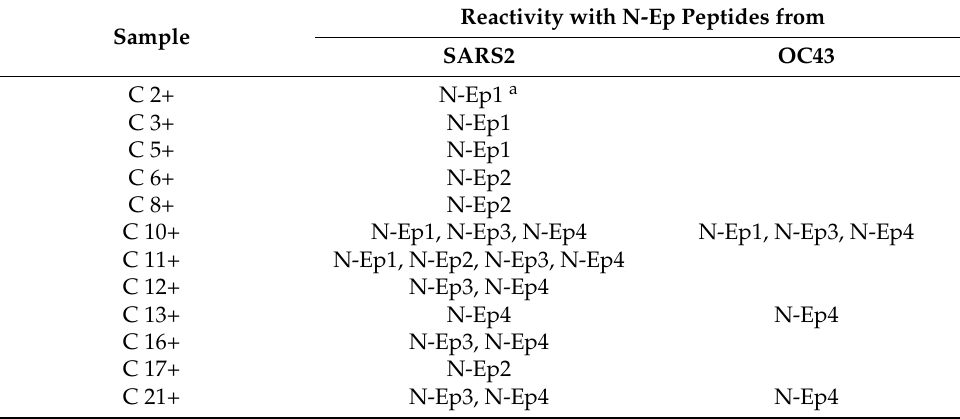
Figure 3. Reactivity against peptides candidates from SARS-CoV-2 and HCoV-OC43 N proteins in healthcare workers with COVID-19 determined by ELISA assays. ( a ) Heatmap with OD450nm readings for each sample. Cutoff for negative binding was established at OD450 = 0.2. ( b ) Frequency of cross-reacting serum samples among all tested serum samples in healthcare workers with COVID-19. Table 1. Summary of reactivity against peptides candidates with functional reactivity from SARS- CoV-2 and HCoV-OC43 N proteins in healthcare workers with COVID-19 determined by ELISA assays. a The numbers indicate the positive ELISA assay from peptides indicated in Figure 1c.